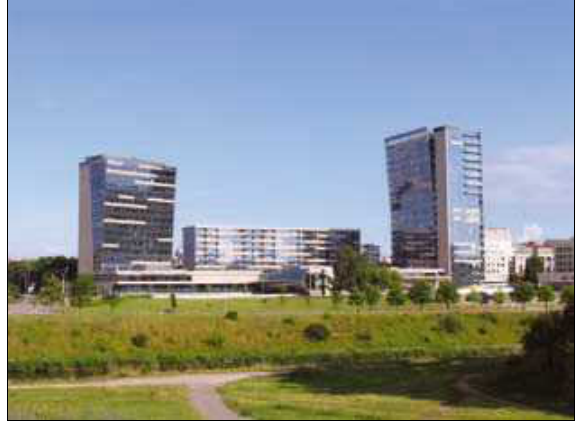
17 pav. Dau­giafu­nkcis kompleksas su­ dau­giabu­čiais „Vilniau­s vartai“, tu­mėno g. (Ua­b „a­rchitektūros kūrybinė gru­pė“) Fig. 17. Mu­ltifu­nctional complex with blocks of flats “Vilniau­s vartai“ in tu­mėnas st. Ua­b “a­rchitektūros kūrybinė gru­pė“